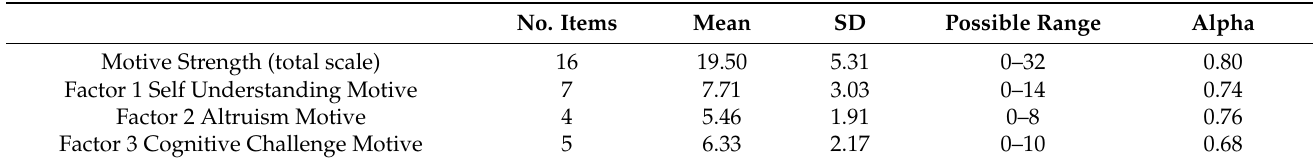
Table 3. Motive Scale Statistics.